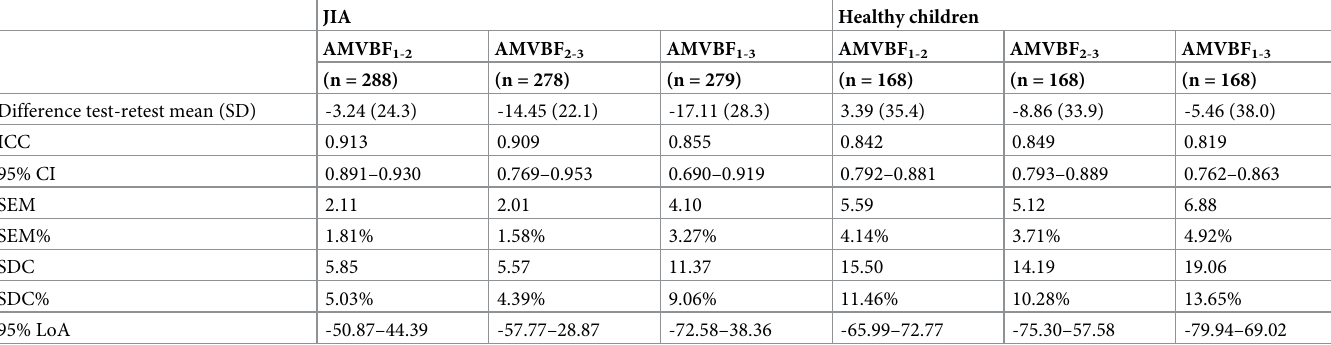
Table 2. Reliability of the anterior voluntary maximum bite force (AMVBF) for children with JIA and healthy children. JIA Healthy